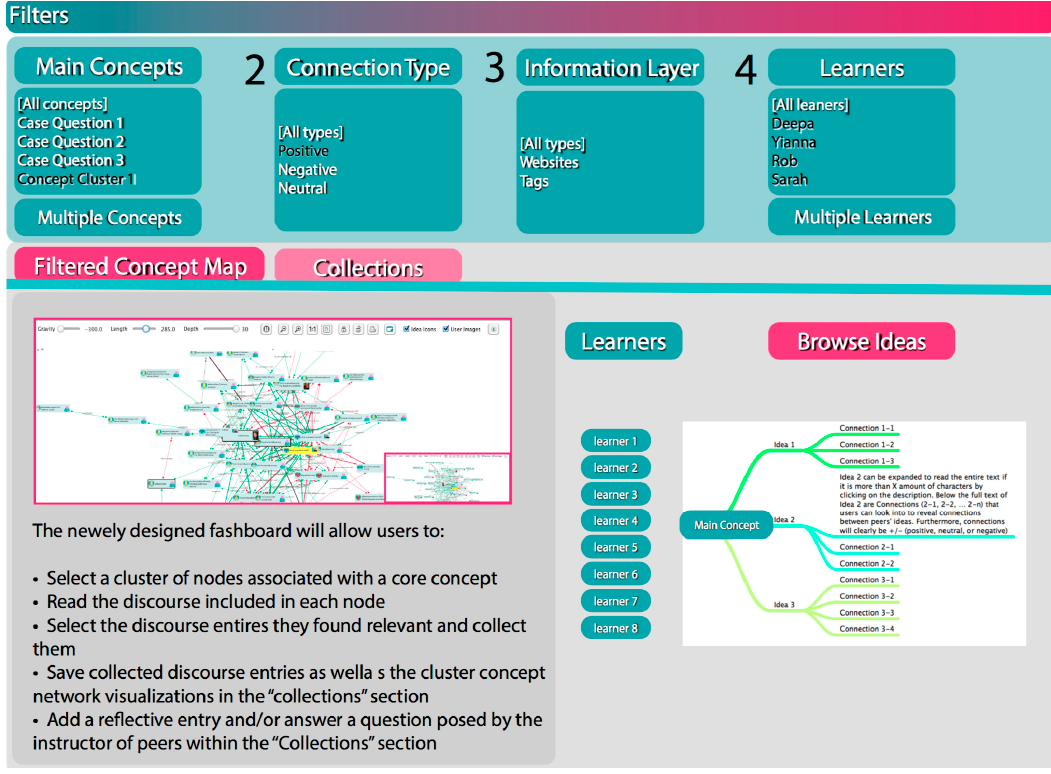
Figure 4. Schematic of Learner ‐ Managed Dashboard.